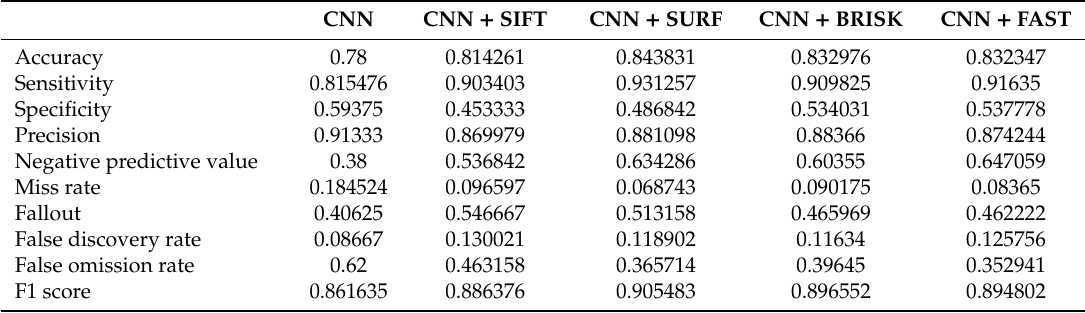
Table 3. Statistical coe ffi cients for classification measurements using the selected keypoint search algorithm with Euclidean metric and CNN.